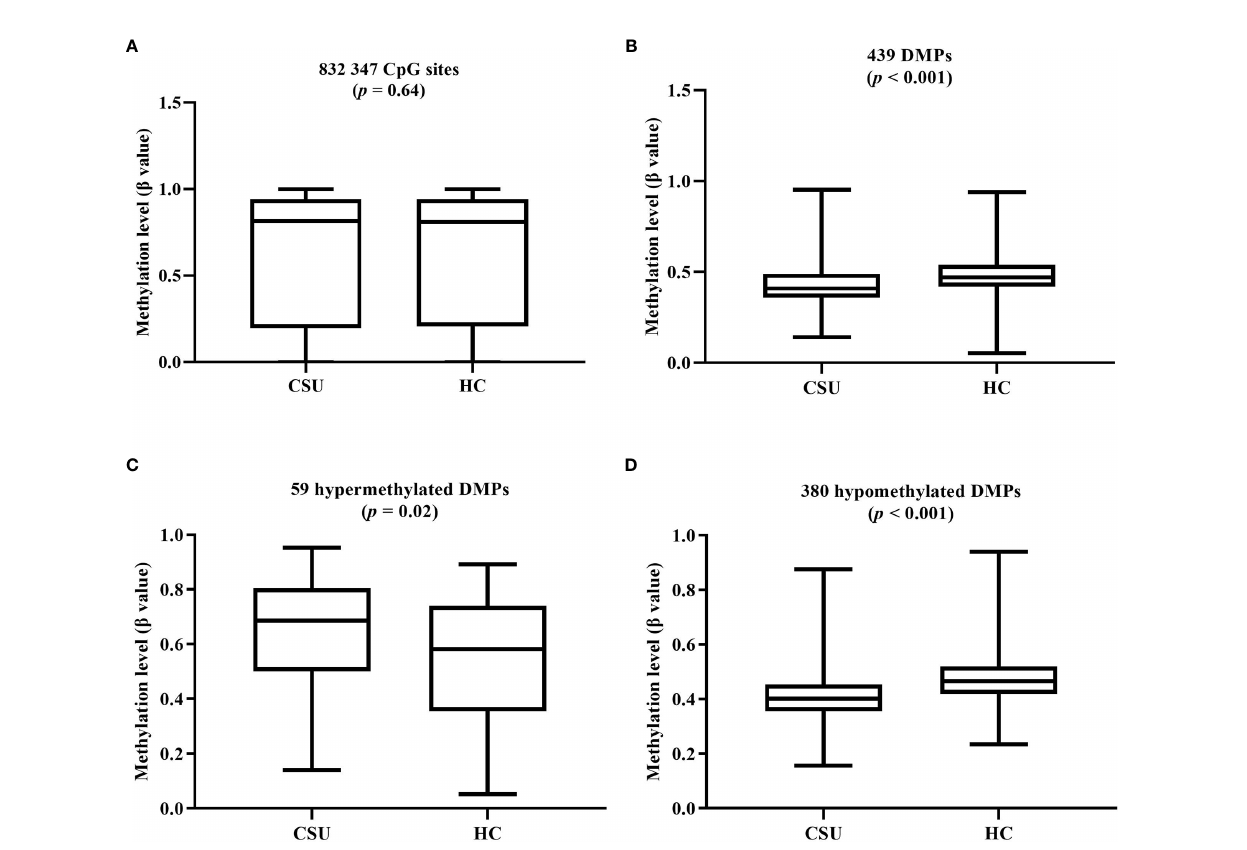
FIGURE 3 | (A) The average global levels of DNA methylation for the 832,347 CpG sites between the CSU patients and the healthy controls (HCs) showed no signi fi cant difference ( p = 0.64). (B) The average methylation levels ( b values) of the 439 differentially methylated positions (DMPs) in the 95 CSU patients were signi fi cantly lower than those in the 95 HCs ( p < 0.0001). (C) With regard to the 59 hypermethylated DMPs, the average methylation levels of the 95 CSU patients were signi fi cantly higher than those of the HCs ( p = 0.02). (D) Concerning the 380 hypomethylated DMPs, the average methylation levels of the 95 CSU patients were signi fi cantly lower than those of the HCs ( p <